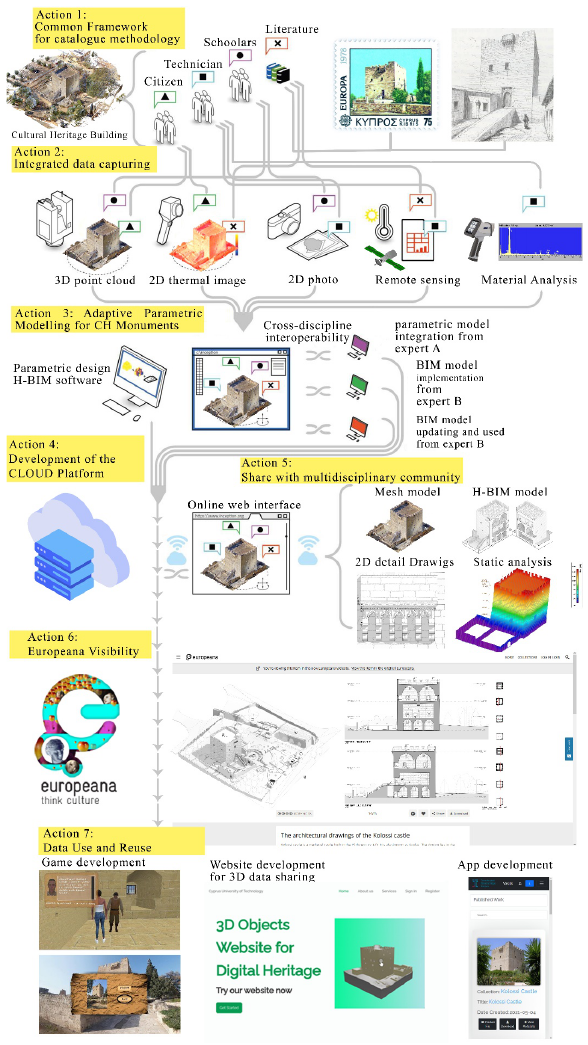
Figure 3. The methodology for the holistic documentation through adaptive parametric design process and the use of Η - ΒΙΜ for life cycle managing, monitoring and